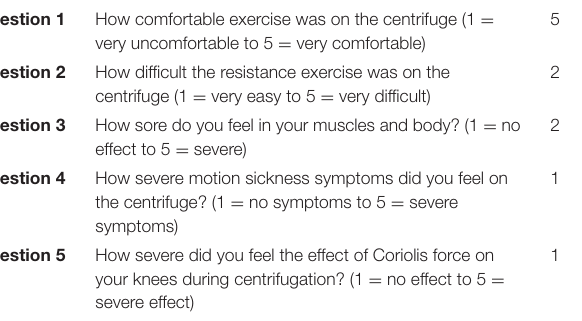
TABLE 4 | Exit survey.